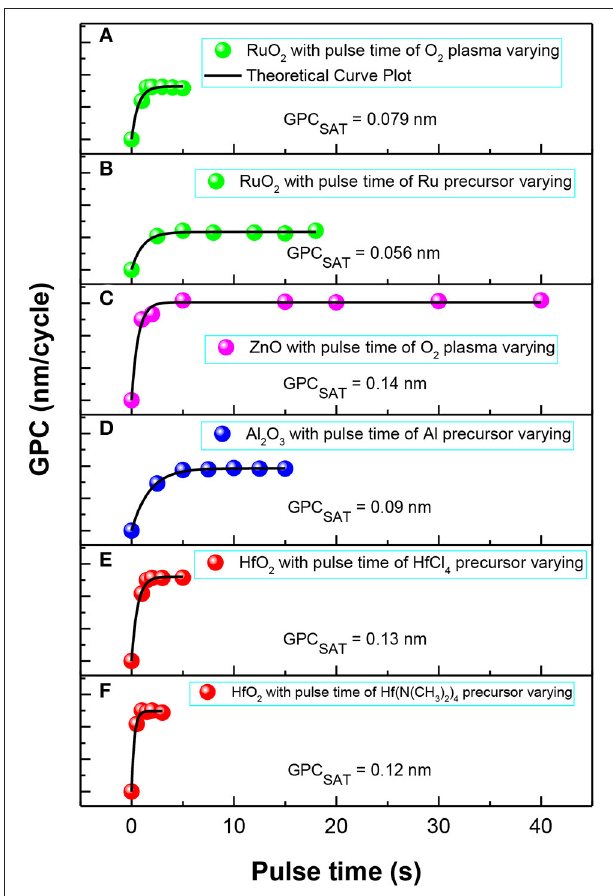
FIGURE 5 | Experimental and simulated GPC vs. pulse time for some experimental data from the literature to different thin films: (A) and (B) RuO 2 , (C) ZnO, (D) Al 2 O 3 , and (E,F) HfO 2